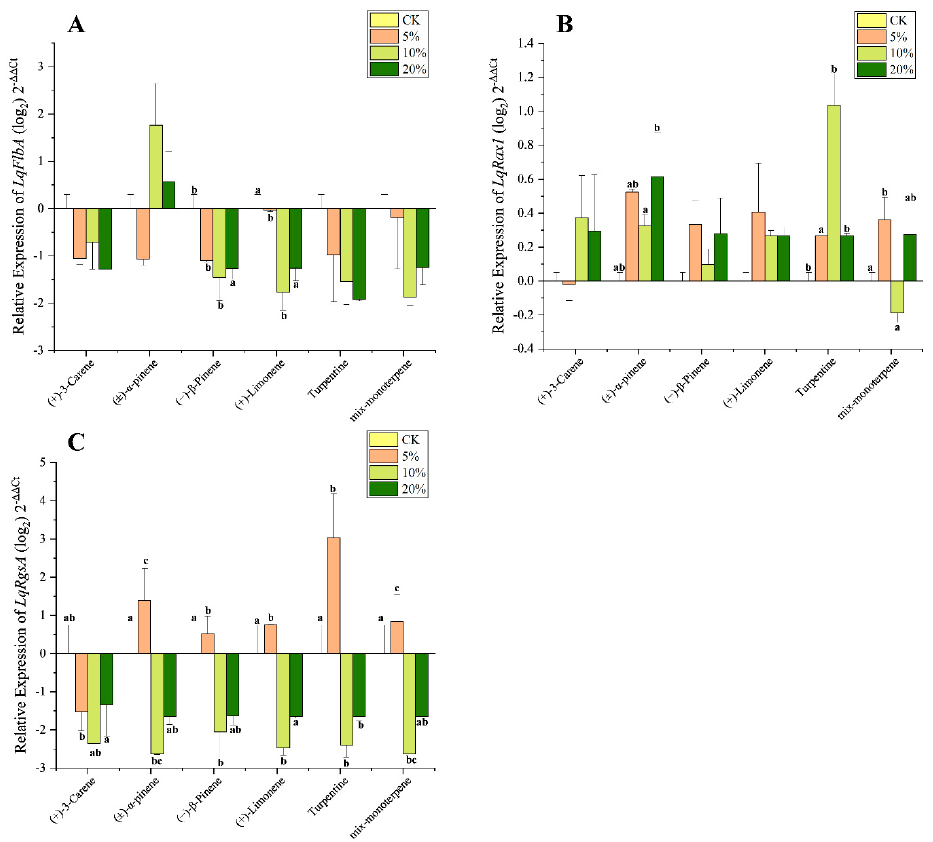
Figure 4. Quantitative expression of the three RGS genes (mean±SE) in L. qinlingensis following treatment with different terpenoids. ( A ) Relative expression of LqFlbA ; ( B ) Relative expression of LqRax1 ; ( C ) Relative expression of LqRgsA . RGSs expressions were normalized with EF1 gene. The 2 −ΔΔ Ct and SE values were transformed at log 2 for plotting. Different letters indicate significant differences at p < 0.05 (Tukey test, no letter means no significant difference) among different concentrations of the same stimulus. Mycelial growth on MEA medium with 200 mL DMSO was set as the control group (CK). Based on the value of CK ( X -axis), the expression levels of other treatments are higher than CK as a positive value (expression up-regulation), and vice versa for a negative value (expression down-regulation).